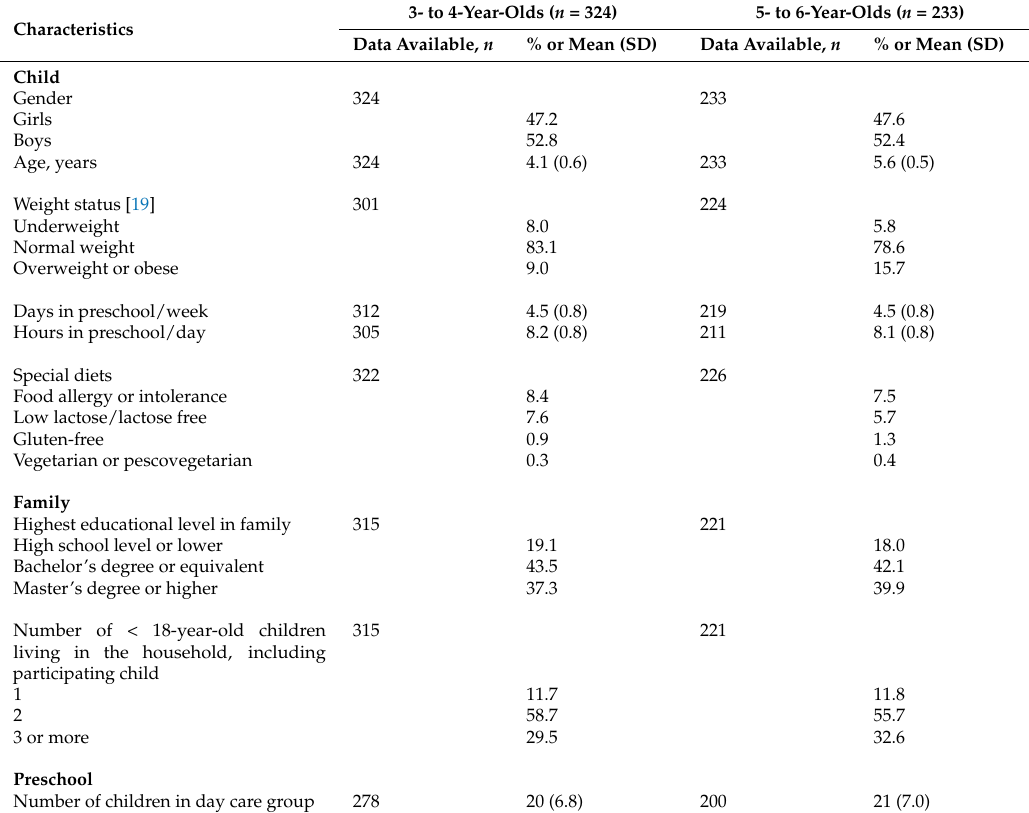
Table 1. Characteristics of sample (total n =